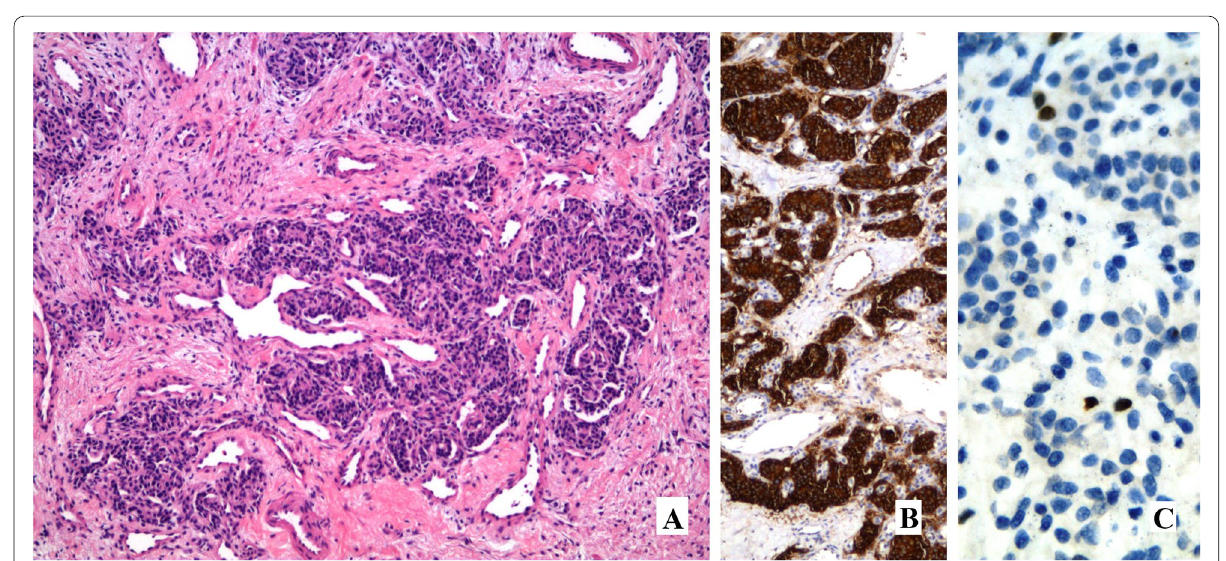
Fig. 1 Photomicrographs of the middle ear paraganglioma. A Tumor cells consisting of epithelioid and spindle cells showing nests in perivascular areas (HE 100). B Positivity of diffuse strong synaptophysin in tumor cells (IHC ×